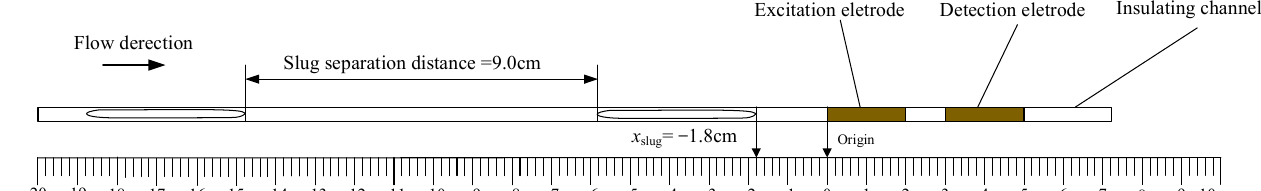
Figure 6. Diagram of relative position of the slug and CID sensor in the axial direction. Figure 7a,b show a photograph captured by the high-speed camera and impedance signals of slug flow with the slug separation distance of 9.0 cm.